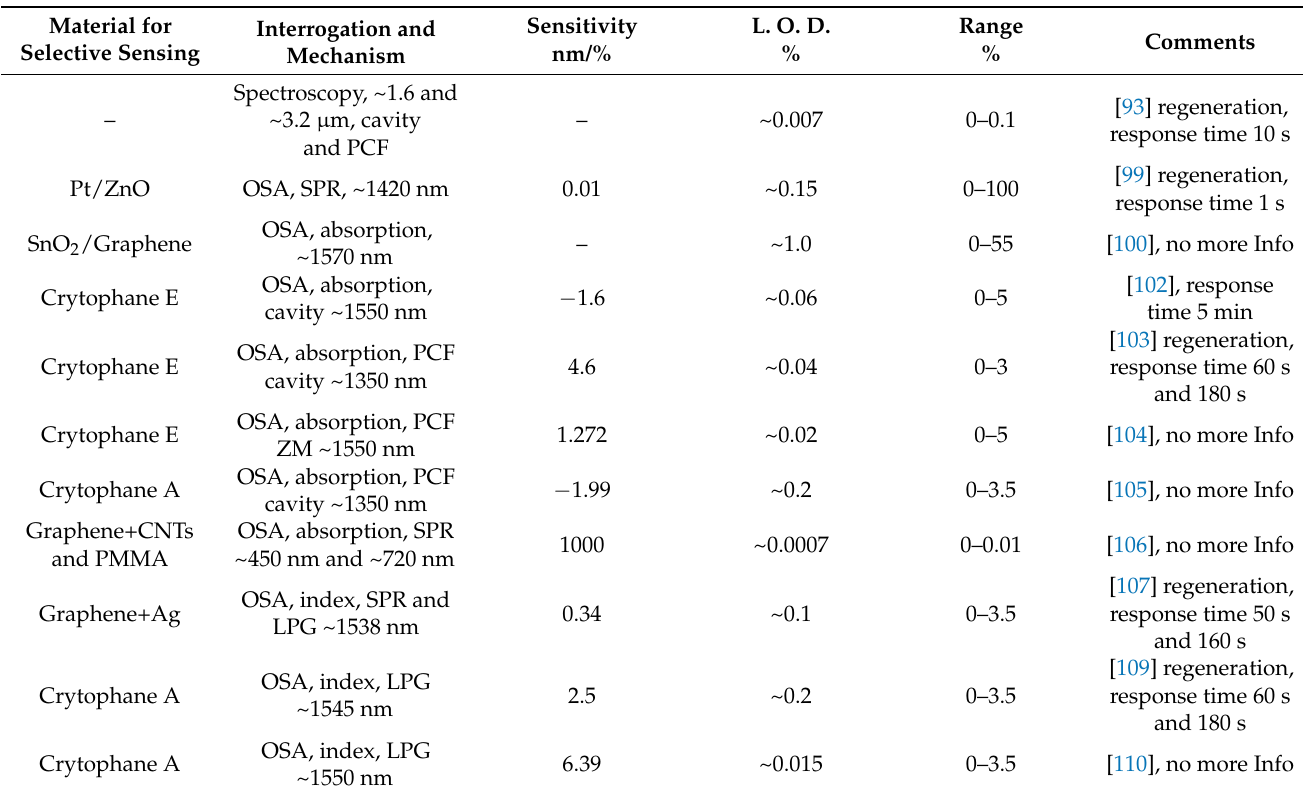
Table 1. Summary of various optical fibre sensors for the detection of